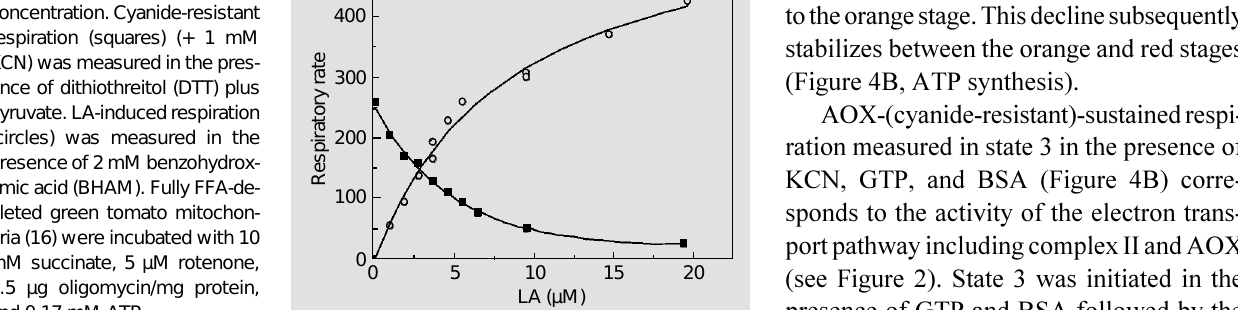
Figure 3 - Cyanide-resistant res- piration and linoleic acid (LA)-in- duced respiration versus LA concentration. Cyanide-resistant respiration (squares) (+ 1 mM KCN) was measured in the pres- ence of dithiothreitol (DTT) plus pyruvate. LA-induced respiration (circles) was measured in